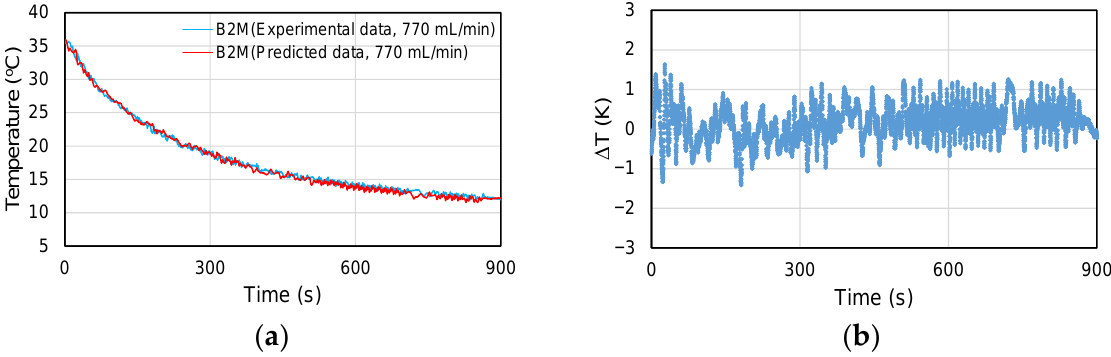
Figure 6. Validation result of C1M-B1M model under the initial temperature of 35 ◦ C and flow rate of 770 mL/min: ( a ) comparison between predicted and experimental data of B2M; ( b ) ∆ T . For the middle layer at other locations, the bottom layer, and different initial tempera- tures, the model is obtained using the same method. The coefficients, R 2 , and MAE of the model for the middle layer and bottom layer under the initial temperatures of 25 and 35 ◦ C are summarized in Table 2. The R 2 values of 0.975–0.997 and MAE values of 0.15–0.69 K demonstrate the acceptable accuracy of the model for the middle layer and bottom layer under the two initial temperatures of 25 and 35 ◦ C. γ is the coefficient of T s , which is related to the convection. At the same initial temperature, the coefficient γ in the bottom layer